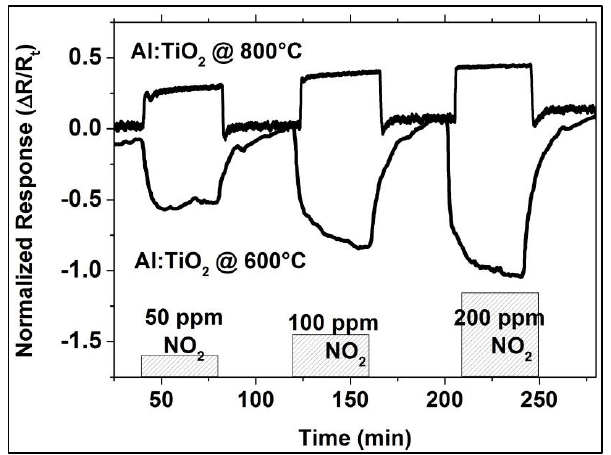
Figure 4. NO 2 response of Al-doped TiO 2 in dry argon environment at 600 °C and 800 °C.